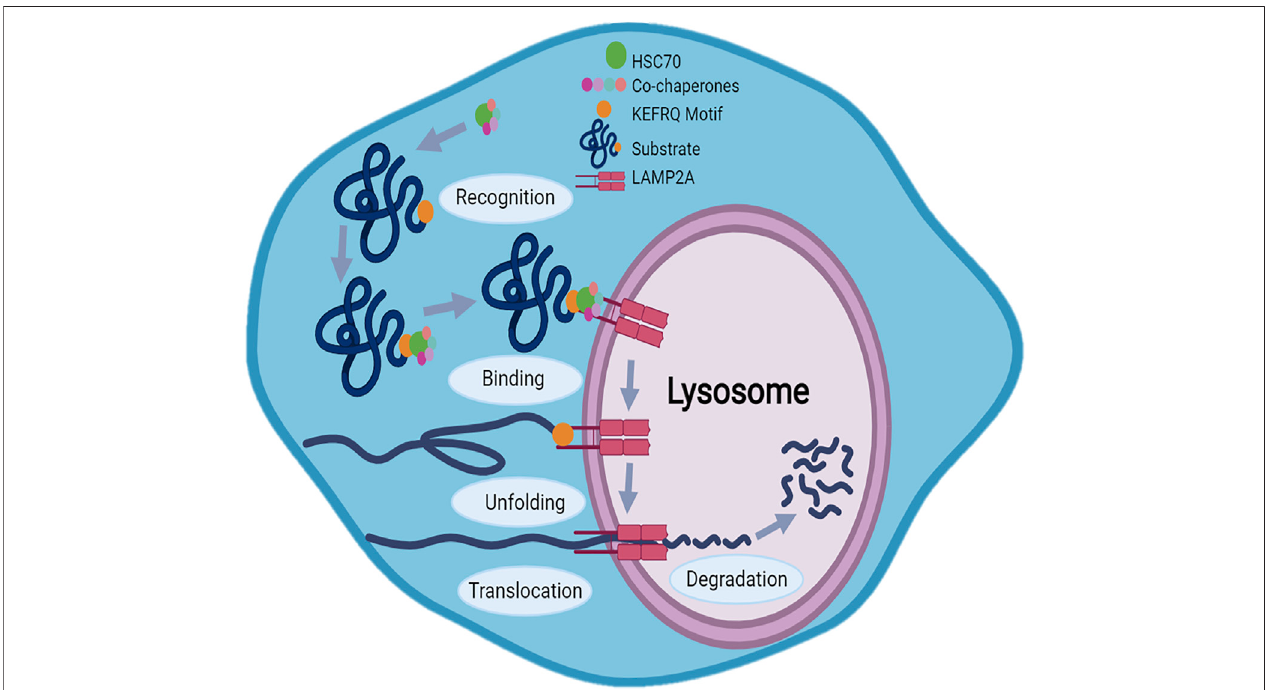
FIGURE2| Mechanism ofChaperone-Mediated Autophagy (CMA): CMAmechanisminvolves fi ve main steps: substrate recognition, lysosomebinding, substrate unfolding, translocation and degradation. The KFERQ motif allows the substrate to be recognized by the heat shock protein 70 (Hsc70) which, thanks also to other chaperones, binds chaperone-substrate complex to the cytosolic tails of the LAMP2A receptor on the lysosomal membrane. After unfolding, LAMP2A acting as a transport channel, translocates protein in lysosome where protein degradation occurs.